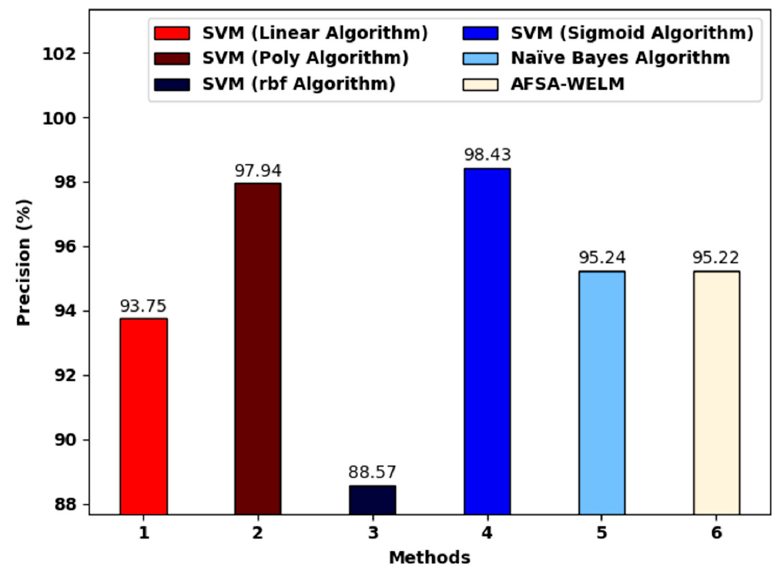
Figure 7. The Prec n analysis of the AFSA-WELM technique and existing algorithms. Figure 7. The 𝑃𝑟𝑒𝑐 (cid:3041) analysis of the AFSA-WELM technique and existing algorithms.